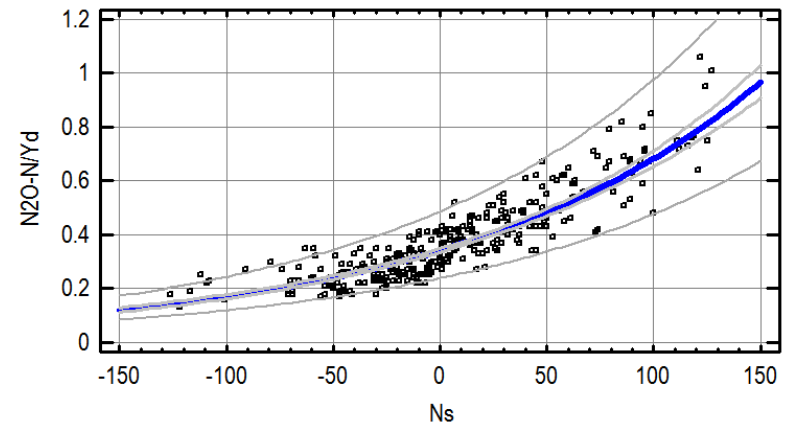
Figure 8. Observed and predicted yield-scaled N 2 O emissions (N 2 O/Yd, kg N·Mg − 1 ) depending on nitrogen surplus (Ns, kg N·ha − 1 ) (N 2 O/Yd = exp( − 1.0763 + 0.00695*Ns; R 2 = 78,2%, n = 320) .